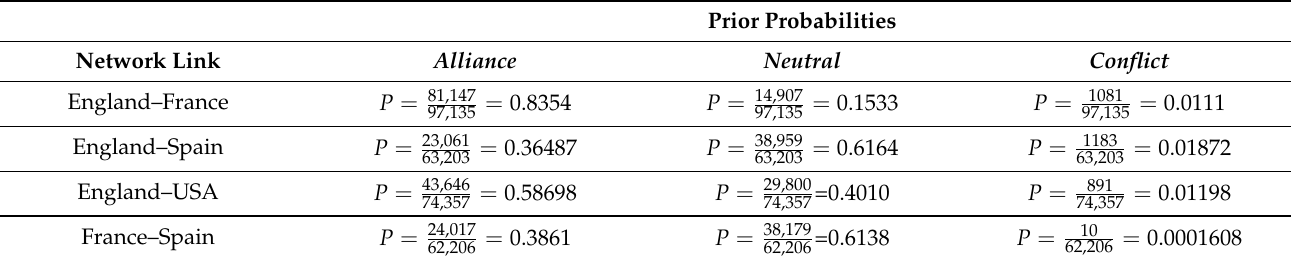
Table 1. Prior probabilities of each of the categories ( Alliance , Neutral , Conflict ) representing the possible states of network links for the generated supervised learning datasets (i.e., discrete time series). The data presented was generated using the database containing the last two centuries (i.e., covering the period from 1816 up to 2007) of state-wise geopolitical information of those countries included in the Correlates of War Project.